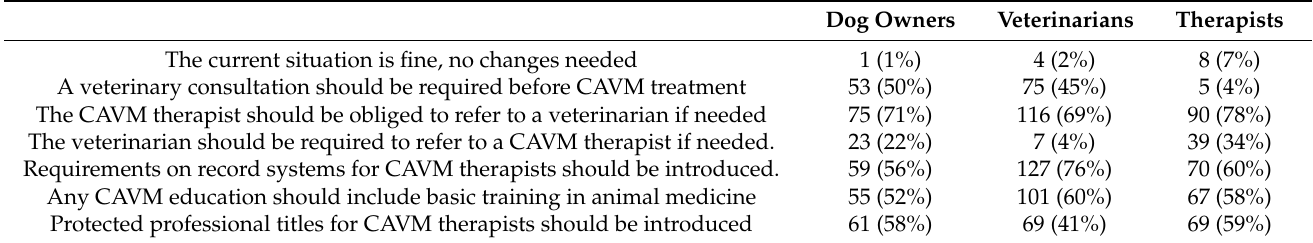
Table 5. The responses of Swedish dog owners ( n = 106), small animal veterinary practitioners ( n = 167) and complementary and alternative veterinary medicine (CAVM) therapists ( n = 116) to a question about regulation of CAVM in animals. Dog Owners Veterinarians